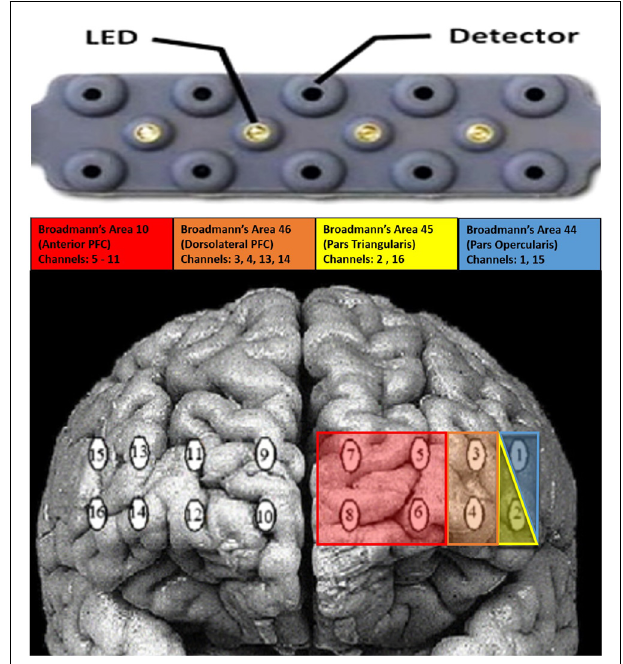
FIGURE 2 | Average projection of the functional near infrared spectroscopy (fNIRS) device over the prefrontal